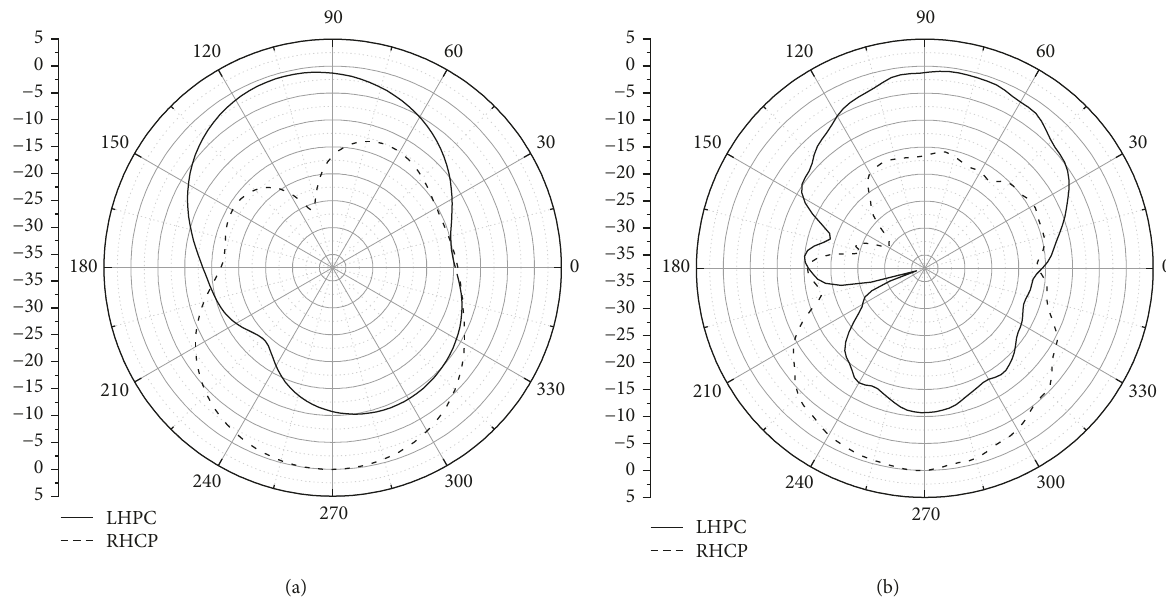
Figure 13: Measured radiation pattern at 3.5GHz: (a) XOZ plane; (b) YOZ plane. Table 2: Comparisons between the proposed antenna and other dual-band circularly polarized microstrip slot antennas.